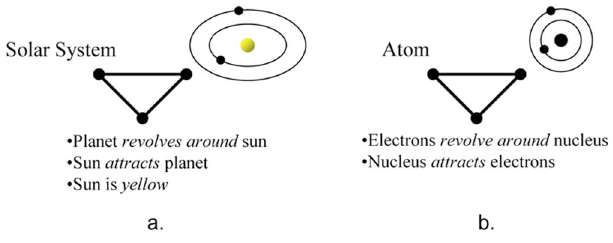
FIG. 2. (cid:1) Color (cid:2) Sign-referent-schema for (cid:1) a (cid:2) the solar system and (cid:1) b (cid:2) the atom.